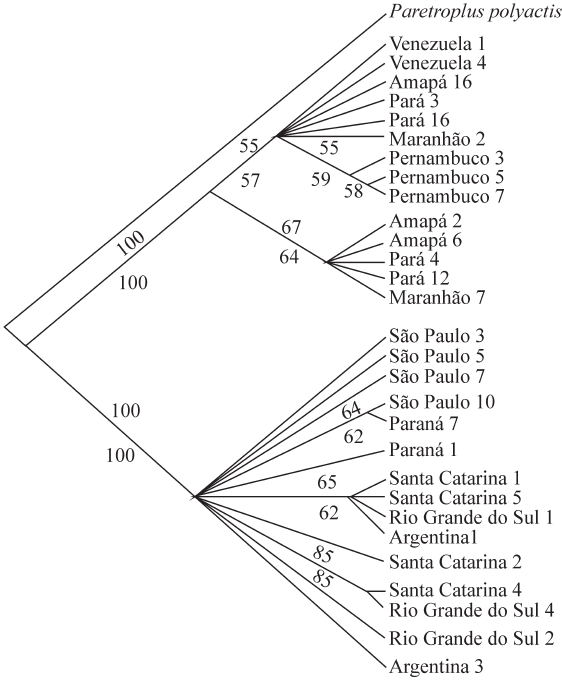
Figure 4 - Phylogenetic tree for Macrodon populations based on 810 base pairs of cytochrome b . When above 50%, numbers in the nodes indicate the percentage of trees out of 1000 bootstrap replicates for the maxi- mum-parsimony (MP, above) and neighbor-joining (NJ, bellow) trees. Paretropuls poplyactis was used as outgroup.